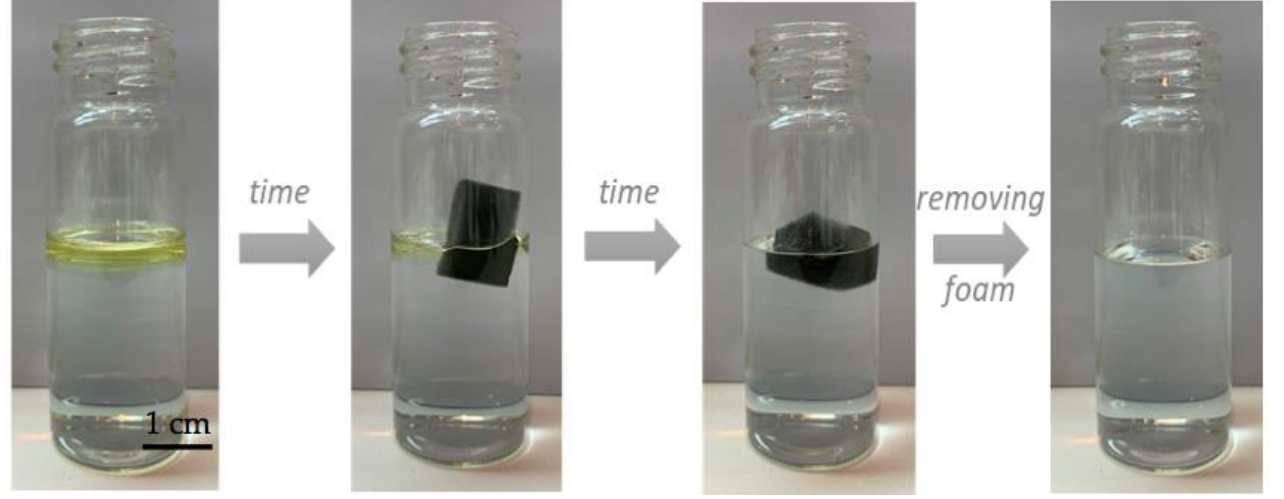
Figure 5. The photo of sorption of diesel fuel from water by M – rGO – ascorb.